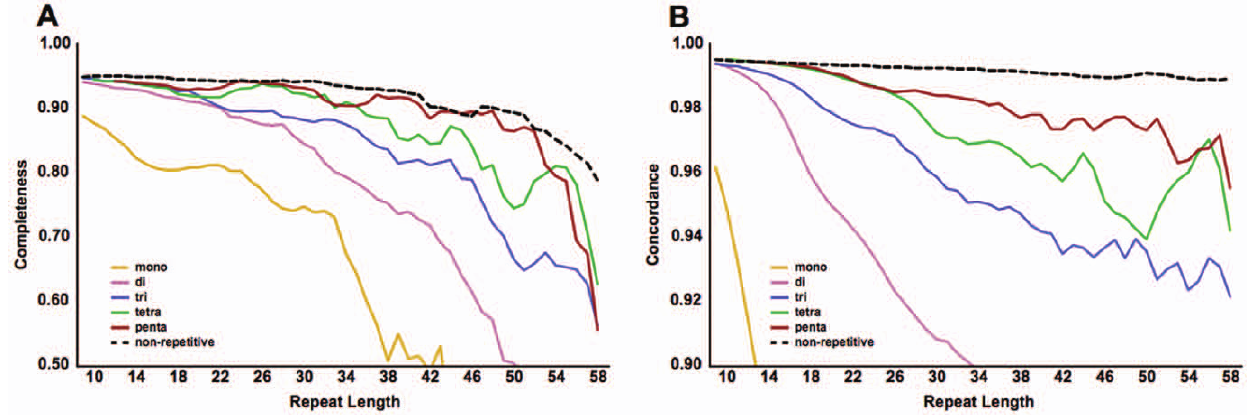
Figure 3. Repeats of shorter unit length are more difficult to sequence. The plotted values are the mean (A) completeness (fraction of repeats with at least two reads passing filtering criteria) and (B) concordance for the genomes in the DGRP panel. Data have been smoothed for clarity (unweighted mean with window size 6 2 bases).